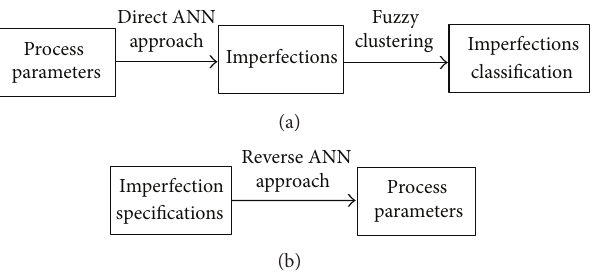
Figure 1: Flow charts for the application of the neuro-fuzzy model.